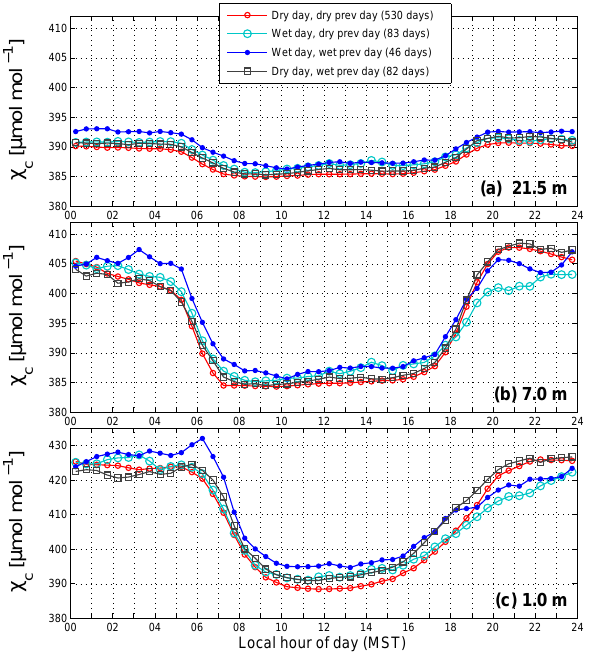
Figure 7. The warm-season mean diel cycle of CO 2 mole fraction χ c at three different heights above the ground. Each line represents a different precipitation state as shown in the legend. These mea- surements are from the warm season in years 2006–2012.